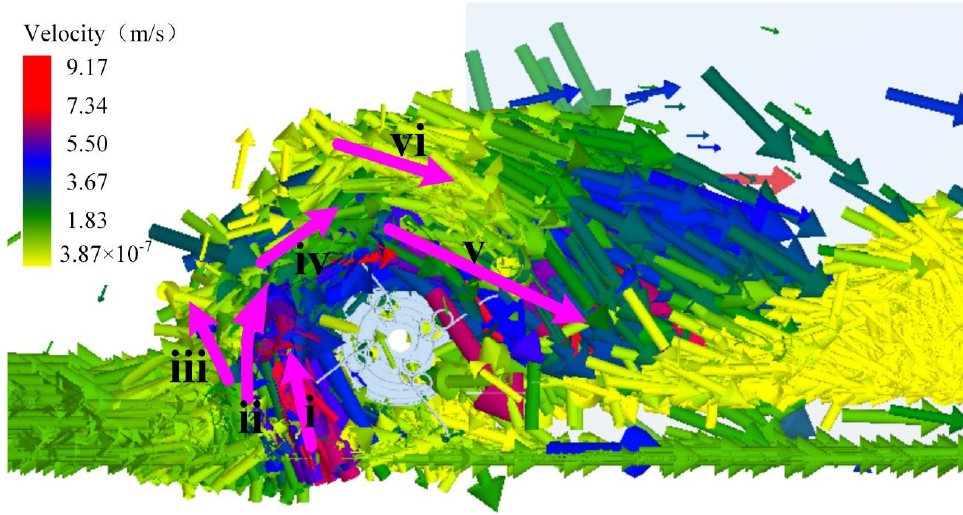
Figure 11. The movement speed and direction of straw.